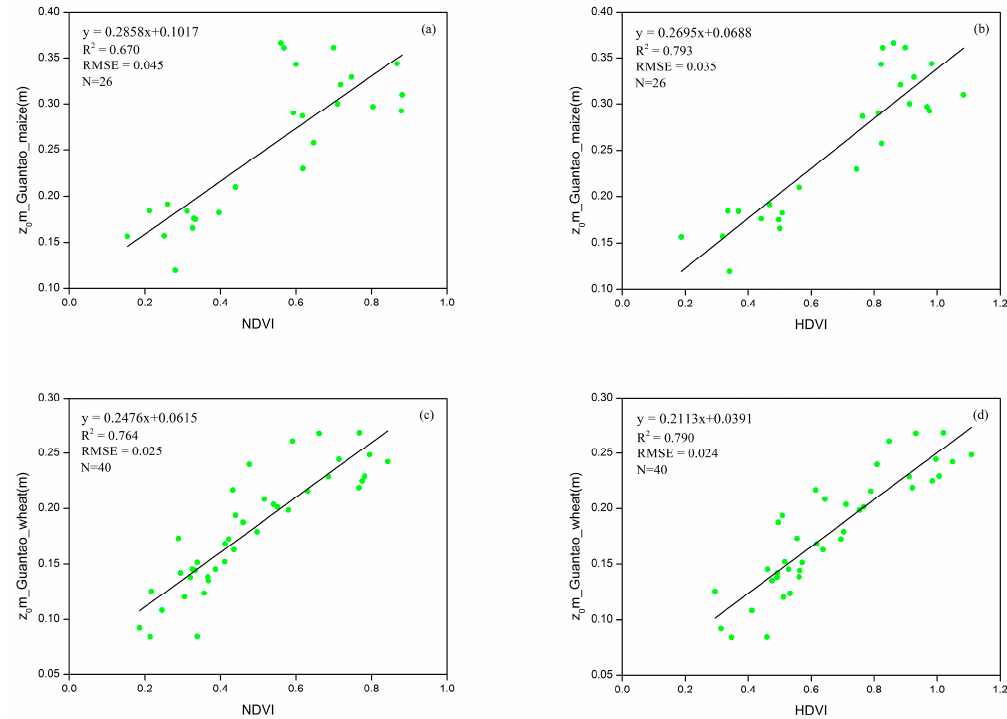
Figure 7. Observed aerodynamic roughness length as a function of: ( a ) the NDVI of summer maize; ( b ) the HDVI of summer maize; ( c ) the NDVI of winter wheat; and ( d ) the HDVI of winter wheat. The data were selected according to the growth period of the specific crop at the Guantao site.